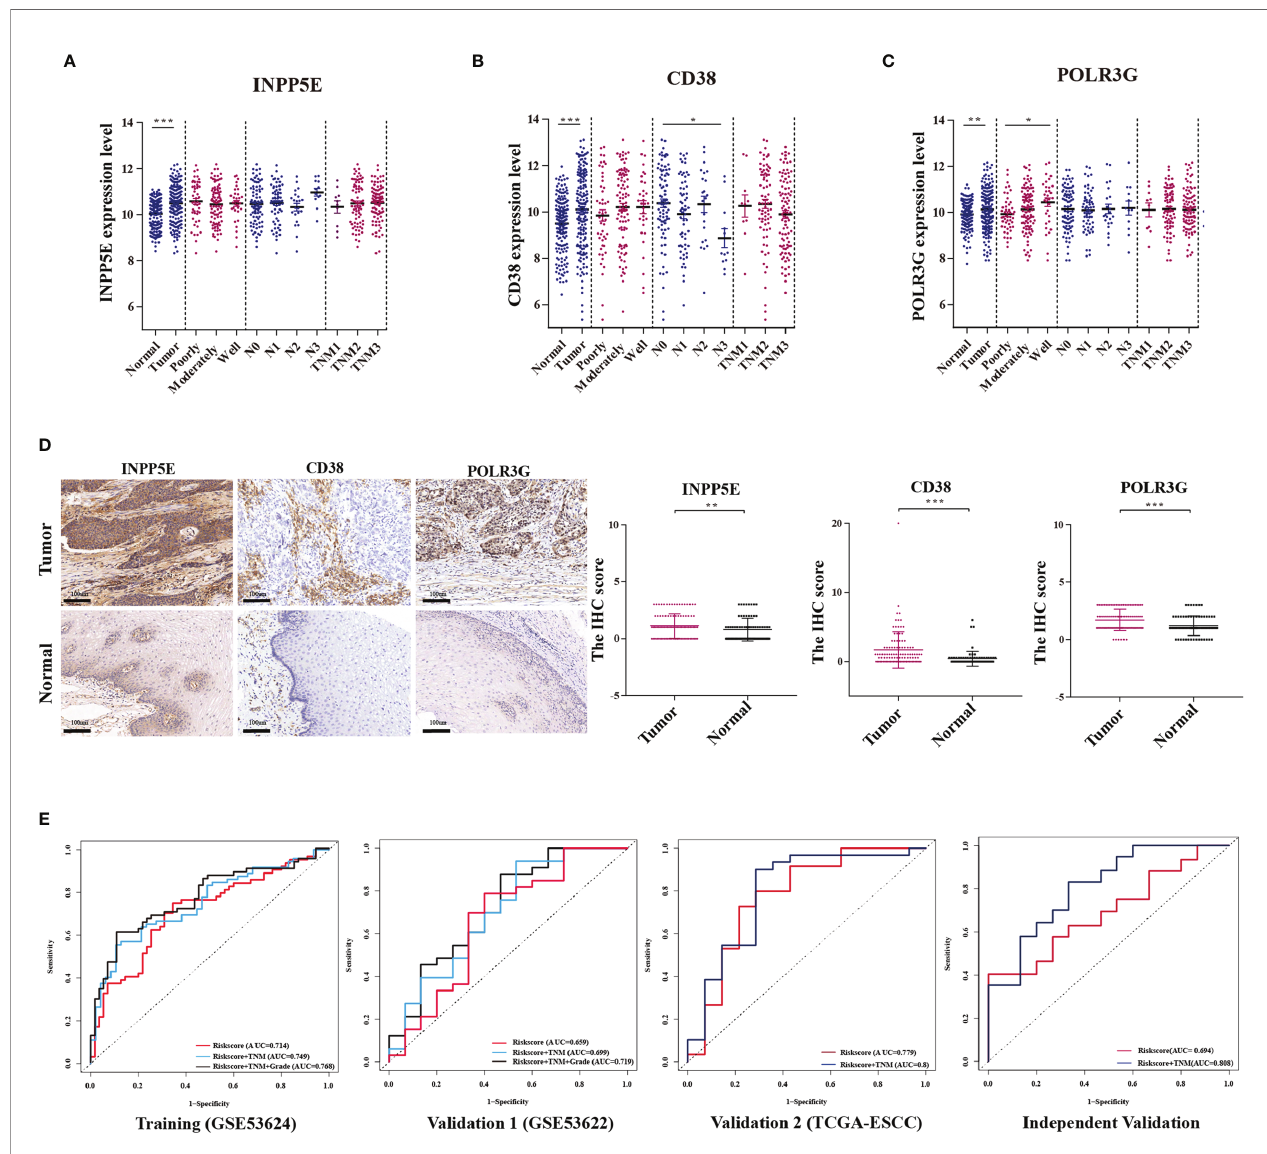
FIGURE 5 | The relationship between the metabolism-related gene signature and clinicopathologic parameters. (A ‒ C) Relationships between the expression of three genes (INPP5E, CD38 and POLR3G) and the tumor characteristics, including comparison with normal tissues, tumor grade (poorly, moderately and well), N stage (N0, N1, N2 and N3) and TNM stage (TNM1, TNM2 and TNM3) were analyzed. (D) The differential expression between tumor and normal tissues was veri fi ed by IHC analysis. (E) The ROC curve of each parameter with AUC scores in the training cohort, validation 1 cohort (GSE53622), validation 2 cohort (TCGA-ESCC) and independent validation cohort. * p < 0.05; ** p < 0.01; *** p <